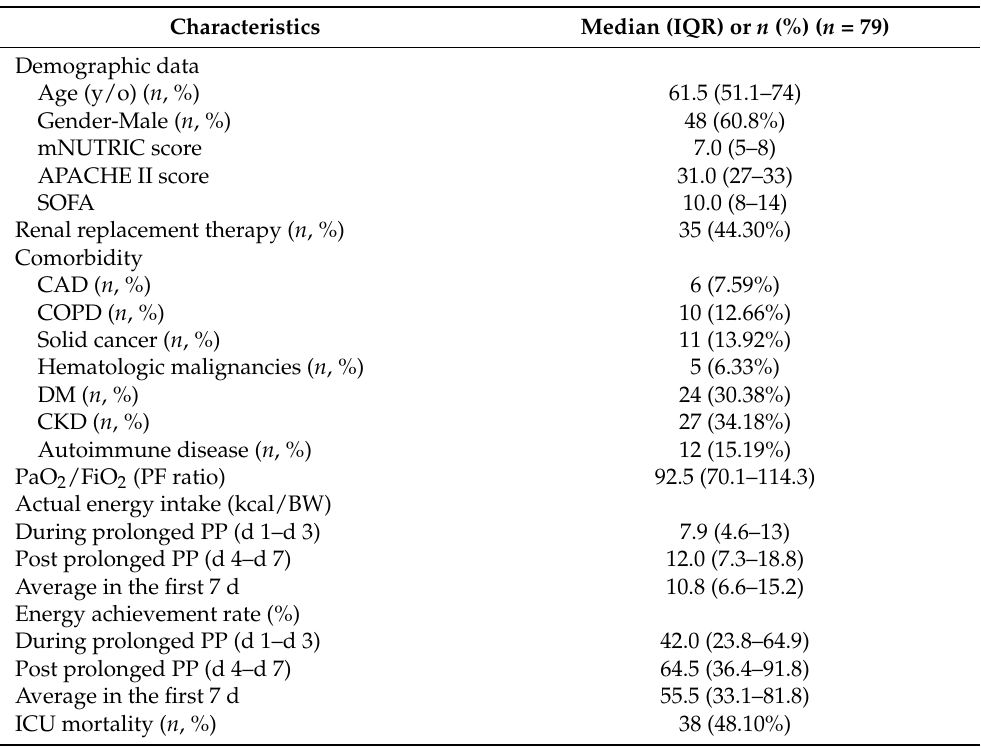
Table 1. Demographic characteristics, severity scores, comorbidities, and clinical outcomes of patients with moderate to severe ARDS receiving prolonged PP therapy in the